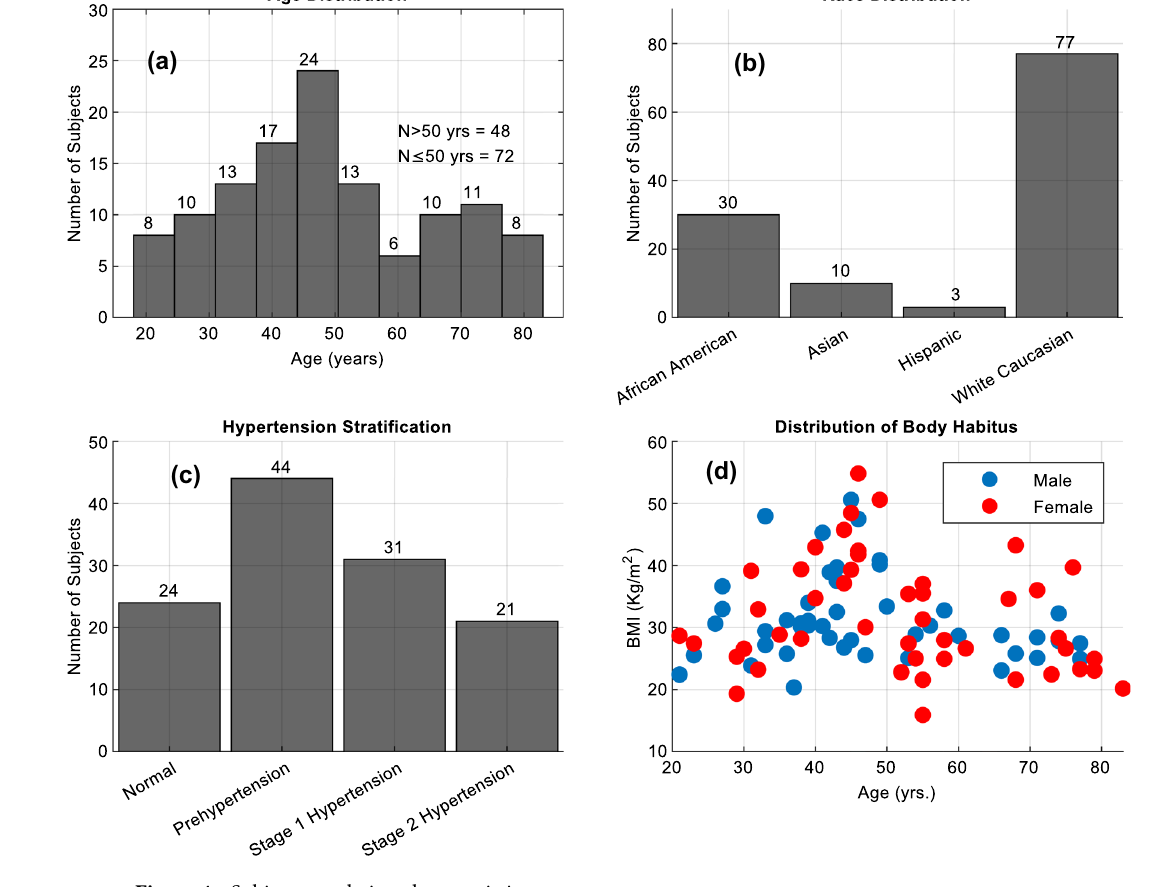
Figure 4. Subject population characteristics.